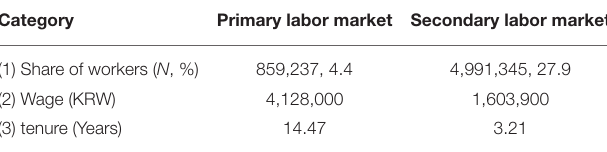
TABLE 1 | Dual labor market structure of